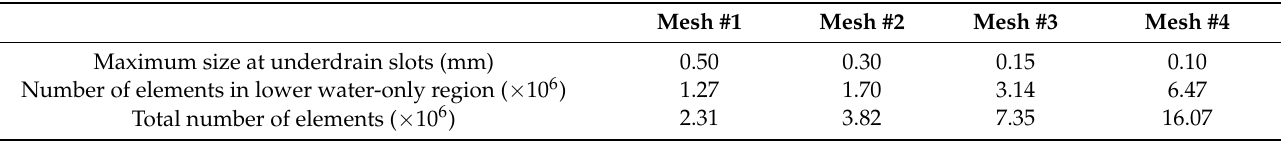
Table 4. General characteristics of the meshes analyzed (with inflation layers). Similar meshes without inflation layers were also adopted. Mesh #1 Mesh #2 Mesh #3 Mesh #4 Maximum size at underdrain slots (mm) 0.50 0.30 0.15 0.10 Number of elements in lower water-only region ( × 10 6 ) 1.27 1.70 Total number of elements ( × 10 6